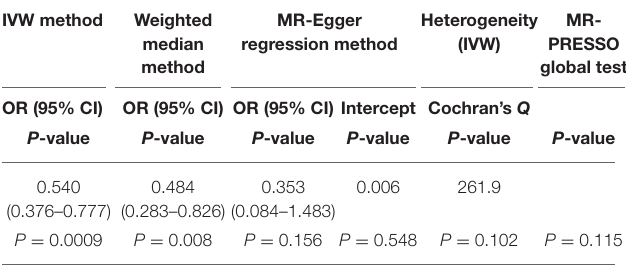
TABLE 1 | MR results of the causal effect of EA on the risk of COVID-19 severity.